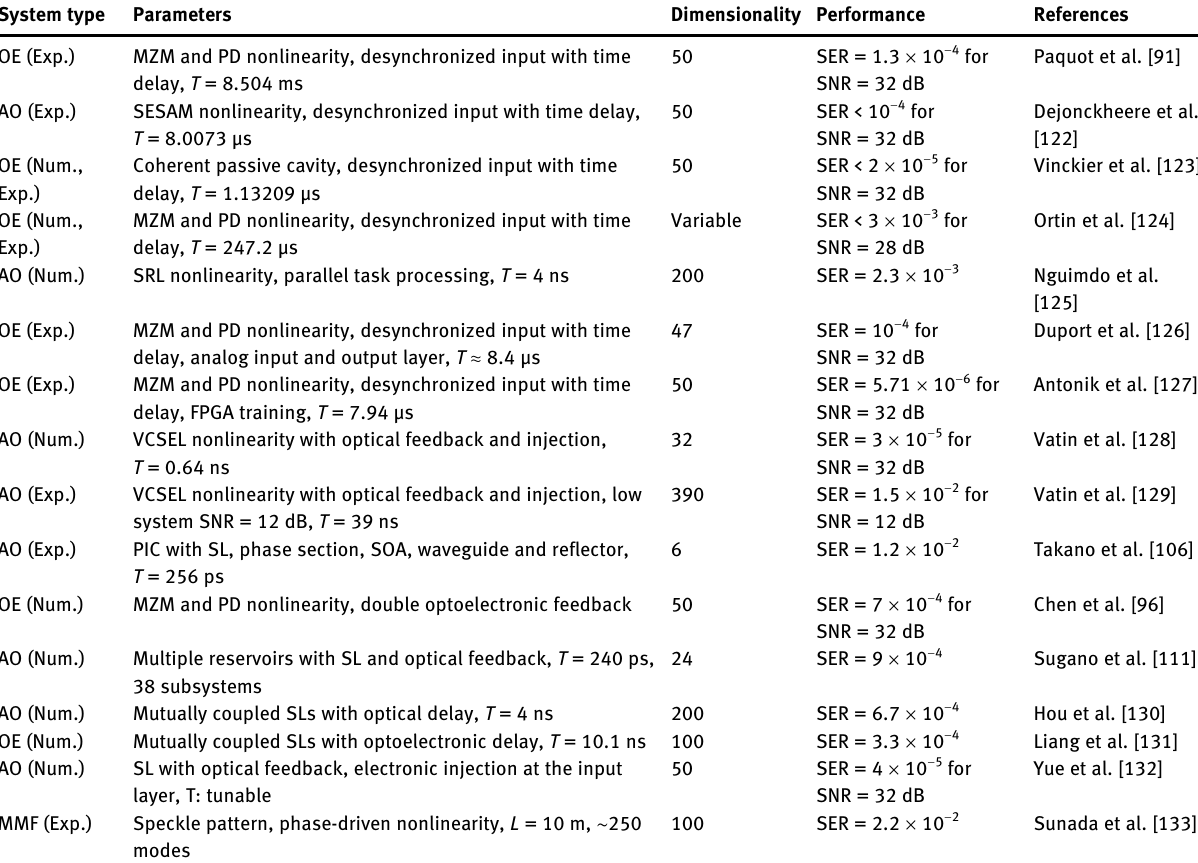
Table  : Photonic neuromorphic systems based on RC and applied on the nonlinear channel equalization benchmark task. AO: all-optical system. OE: optoelectronic system. PIC: photonic integrated circuit. SRL: semiconductor ring laser. Exp.: experimental investigation. Num: numerical investigation. T: time delay. L: